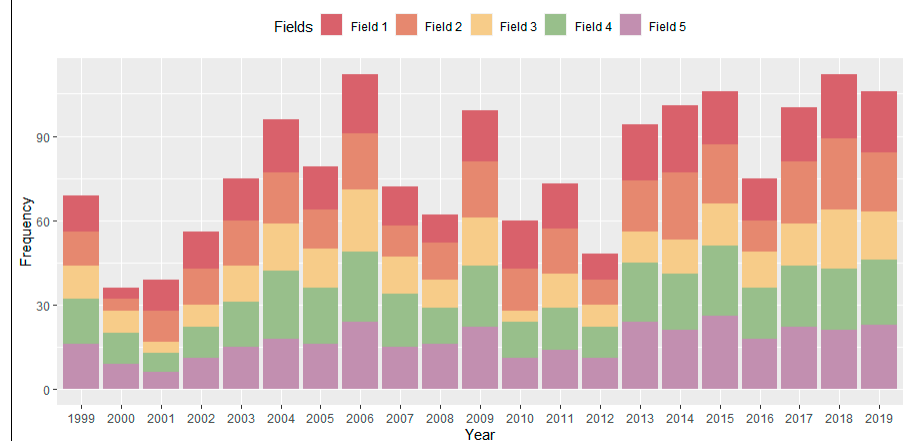
Figure 3. Number of images by year in the five fields.